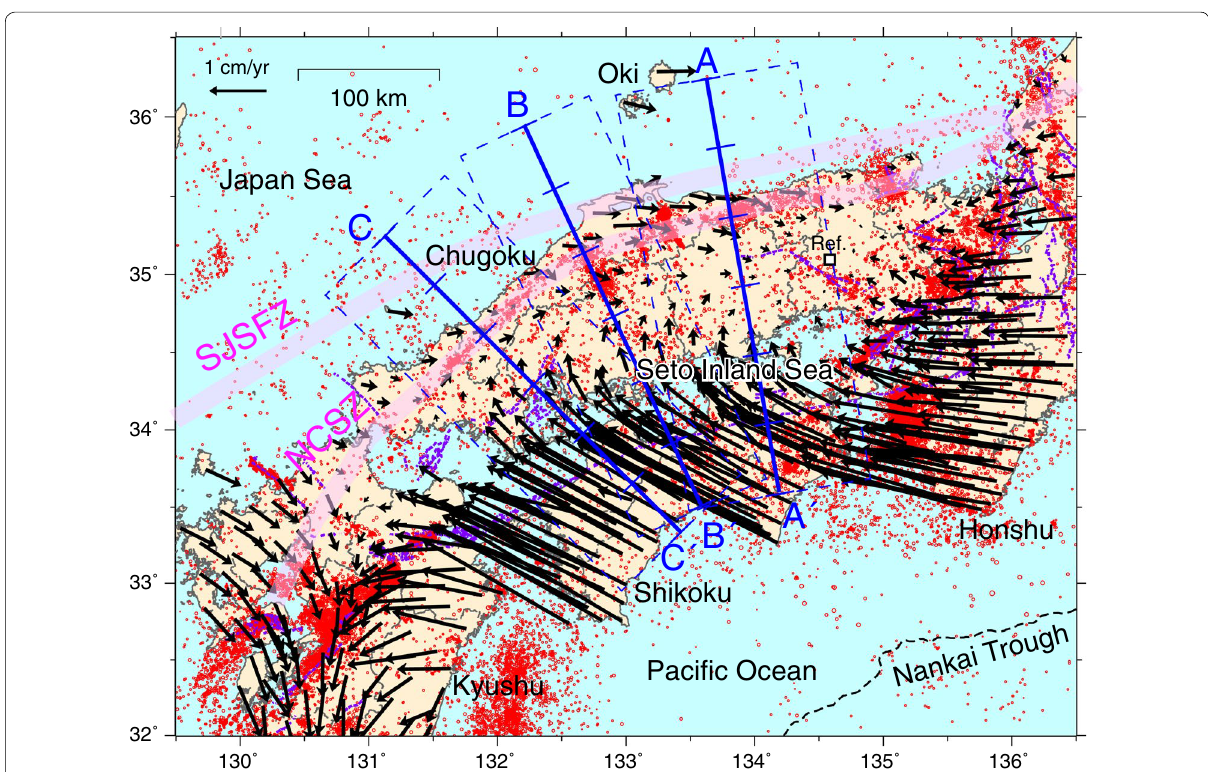
Fig. 1 GNSS velocities in southwest Japan from April 2005 to December 2009. A reference station of the velocities is 950344 (Hyogo-Ichinomiya). The Northern Chugoku Shear Zone (NCSZ) and Southern Japan Sea Strike Slip Fault Zone (SJSFZ) are right-lateral shear zones proposed by Gutscher and Lallemand (1999) and Itoh et al. (2002), respectively. Purple broken lines are major active faults (HERP 2017). Red dots show a shallow seismicity with magnitude of 2 and a depth of <30 km during 1923–2016. Three broken rectangles show locations of velocity profile (Fig. 2). Ticks on lines in ≥ the rectangles are plotted with an interval of 50